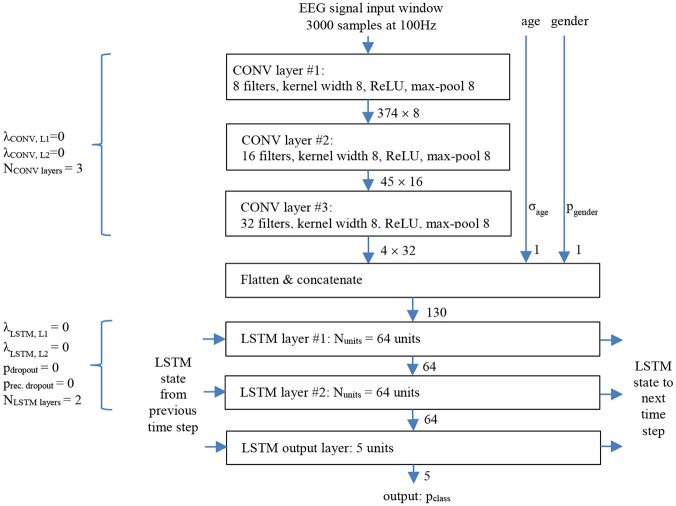
Temporally unrolled CNN/LSTM sleep stager network with baseline parameters shown for one LSTM time step, i.e., corresponding to one 30 s EEG signal window.